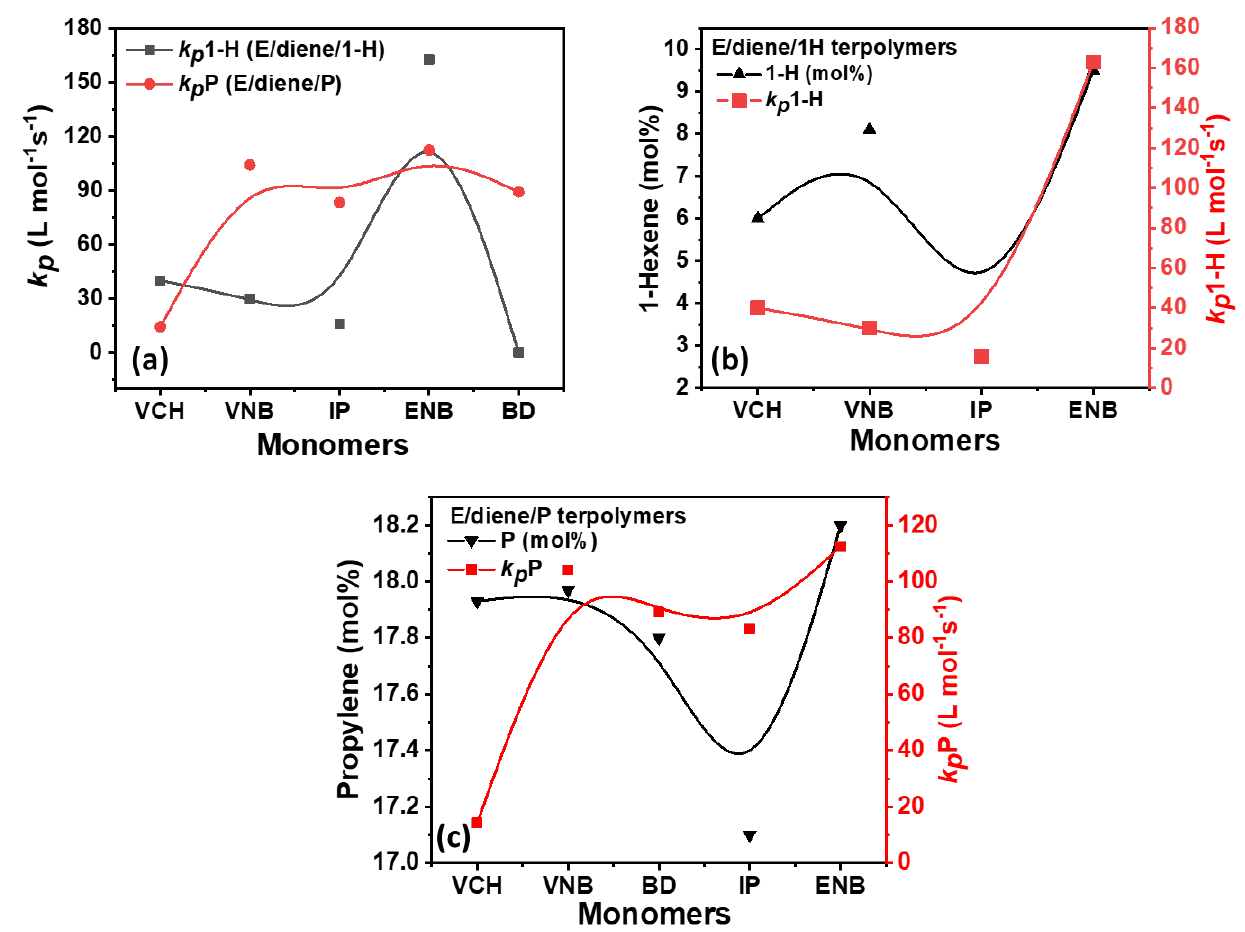
Figure 9. ( a ) Comparison of k p 1-H and k p P in E/diene/1-hexene and E/diene/P polymerizations, ( b ) relationship between 1-hexene mol% and k p 1-H in E/diene/1-hexene terpolymerization, ( c ) relationship between propylene mol% and k p P in E/diene/propylene polymerizations.